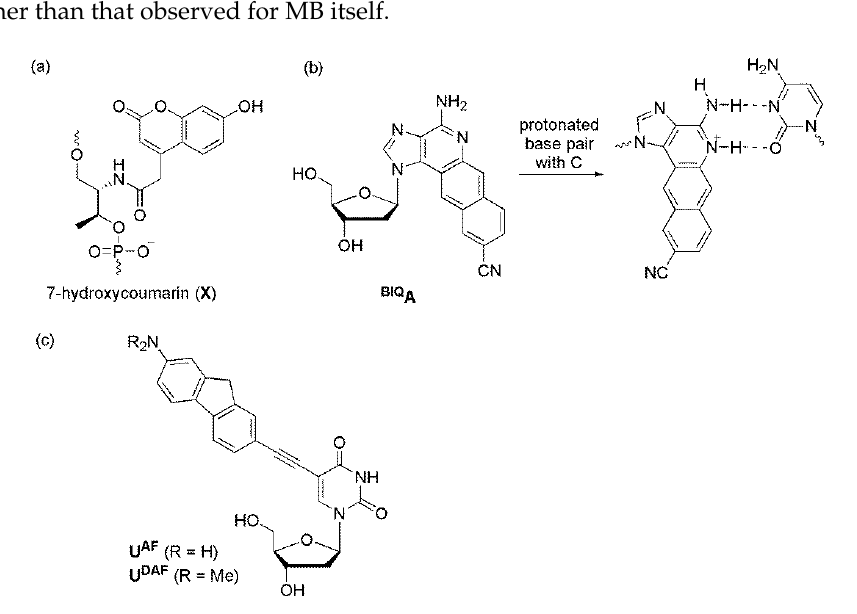
Figure 17. pH-sensitive probes. ( a ) 7-hydroxycoumarin; ( b ) BIQ A ; and ( c ) U AF and U DAF .